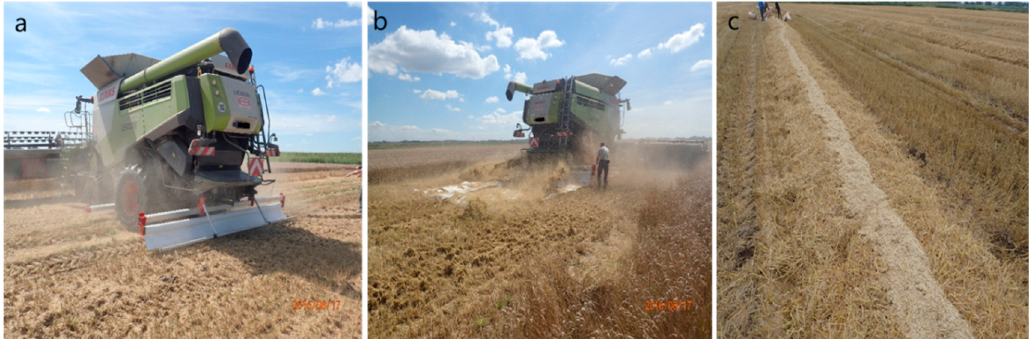
Figure 2. ( a ) Unrolling sheet installations below the combine harvester and ( b ) in operation. ( c ) Chaff placed on the straws.